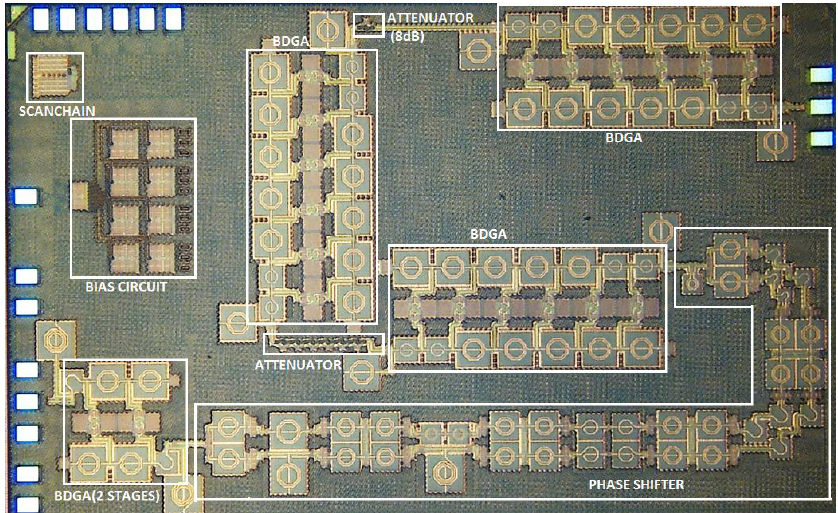
Figure 17. A microphotograph of the X-band bi-directional transmit/receive module.